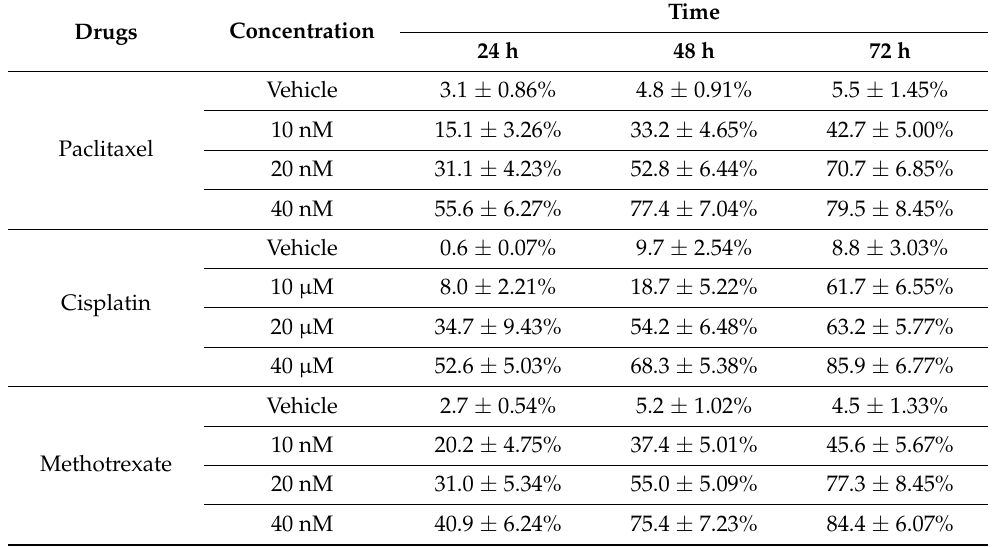
Table 2. Summary of the cell apoptosis rate at the indicated concentrations 24 h, 48 h and 72 h after the drug’s